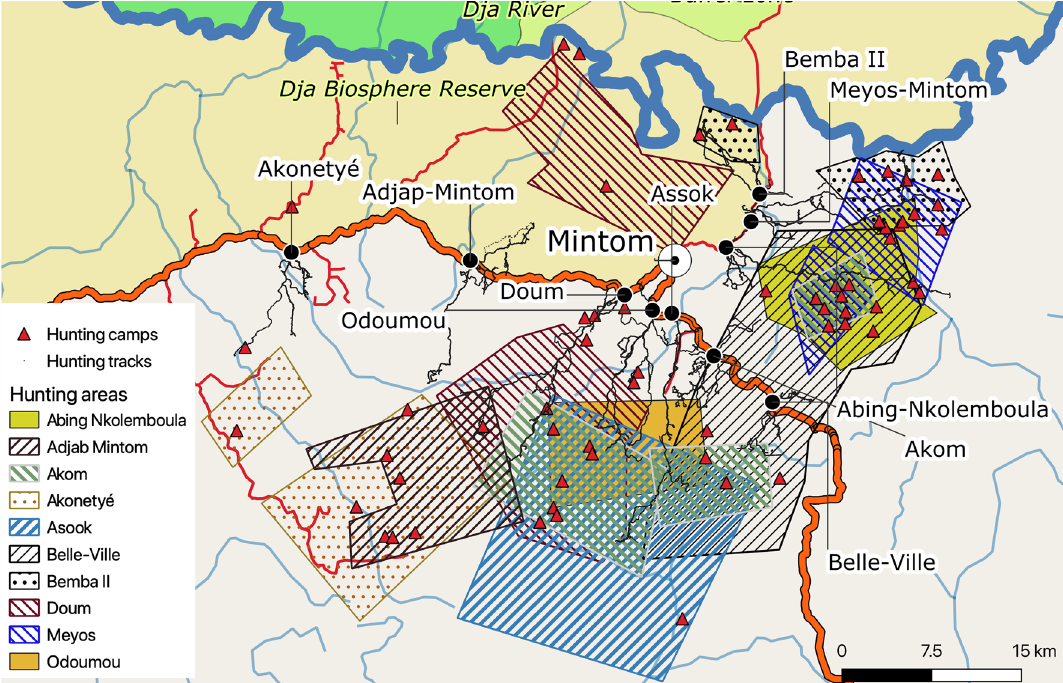
Figure 2. Participatory mapping territories and hunting tracks for the 10 Baka study villages in southeastern Cameroon. The background map was created using QGIS version 3.16.0-Hannover (https ://qgis.org/en/site/) from public domain map datasets from Open Street Map (www.opens treet map.org), diva-gis (diva-gis.org) and Natural Earth (http://www.natur alear thdat a.com) and the published map of the Dja Biosphere Reserve 89